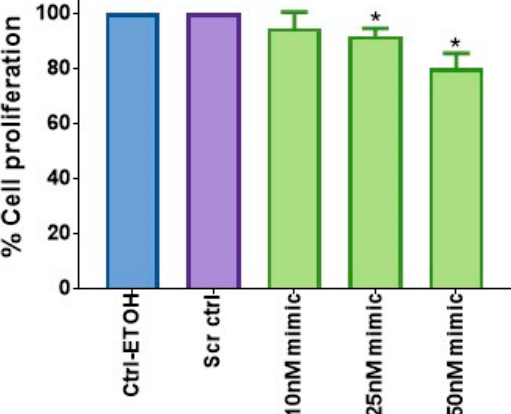
Figure 2. The effect of miR-149-5p overexpression on the proliferation of the A549 cell line. A549 cells were treated with vehicle (0.1% ETOH) as a control, or transfected with Scr ctrl as a transfection control, or with different doses of miR-149-5p mimics. After 48 h of incubation, the cell proliferation was analyzed via the CV assay. Data are expressed as the mean ± SE of three separate experiments. Statistically significant differences (* = p < 0.05) were observed, according to Student’s t -test, between the control groups and cells treated with various doses of the miR-149-5p